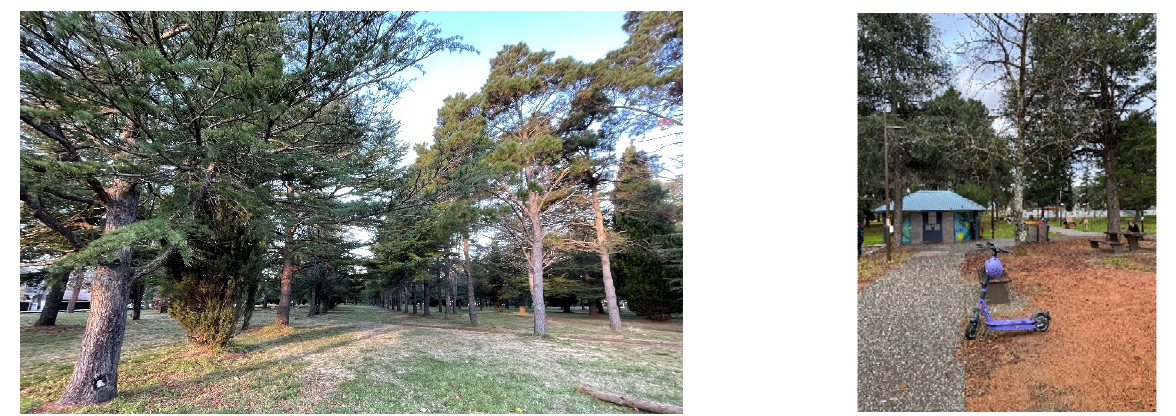
Figure 7. Haig Park in Canberra was established in 1921 and consists of exotic pine trees (such as Cedrus deodara and Pinus radiata ). Right photo shows a part of the interventions to make it multifunctional by providing some amenities. Photos: F. Mofrad, 2022.